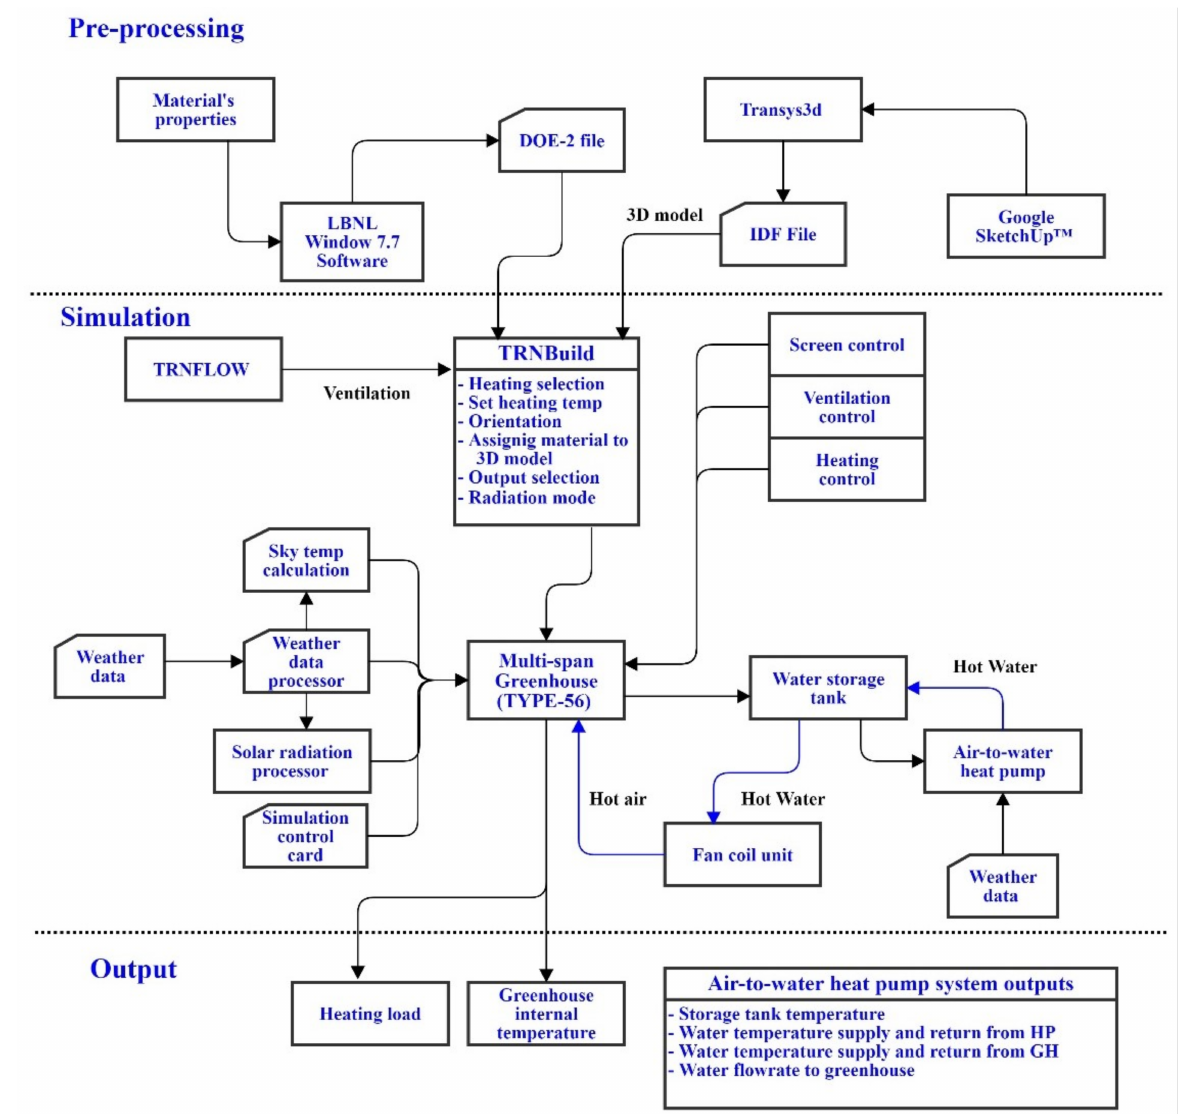
Figure 7. Flow chart of BES modeling using